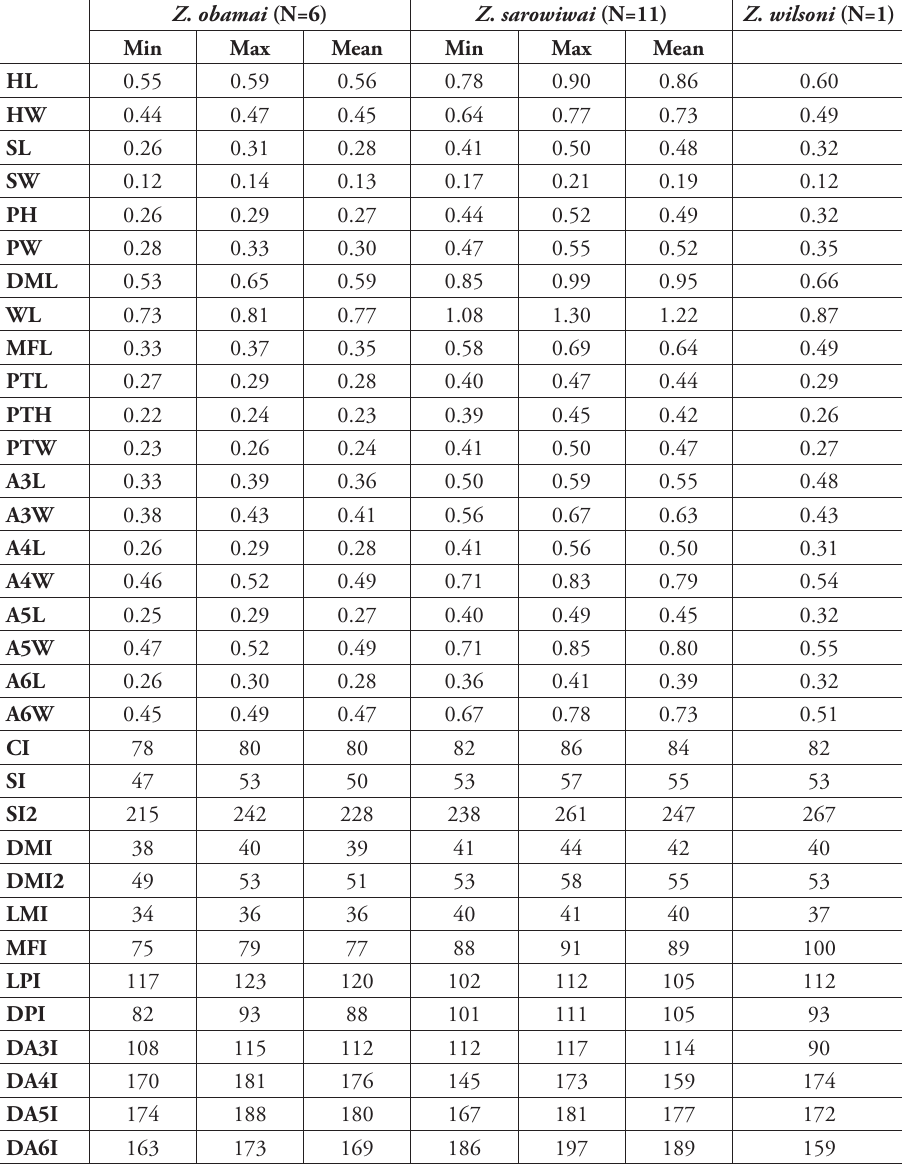
Table 4. Morphometric data of the three species treated in this study. Z. obamai